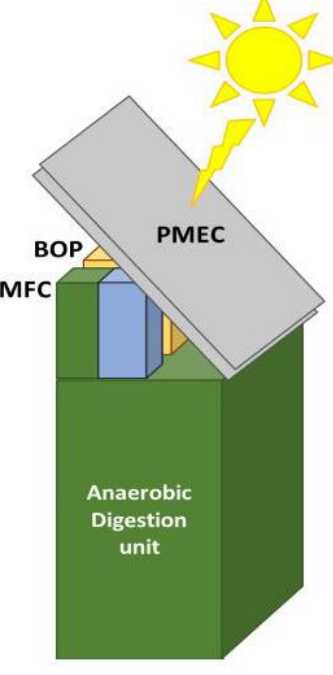
Figure 13. Tentative architecture of the PMEC